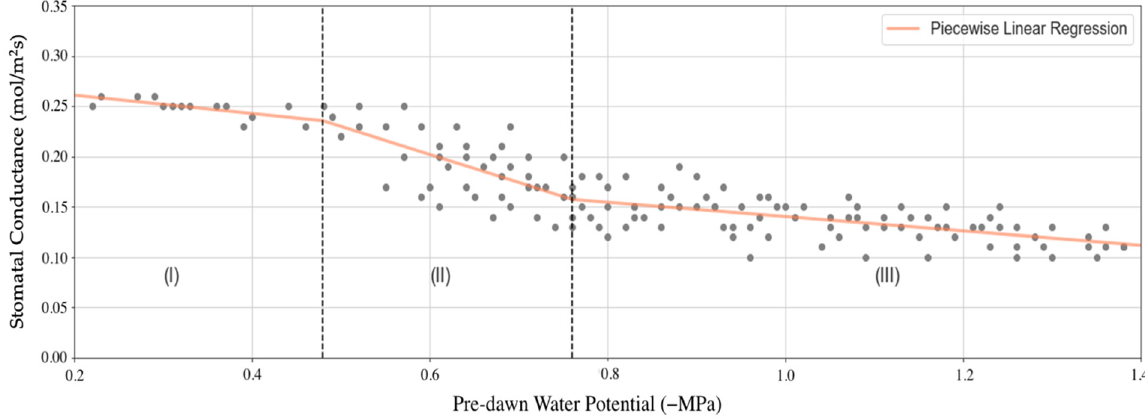
Figure 5. Relationship of stomatal conductance (gs) and pre-dawn water potential. Three phases were segmented (with dashed lines) after applying piecewise linear regression methodology. The Roman numerals indicate the appearance order of the phases.